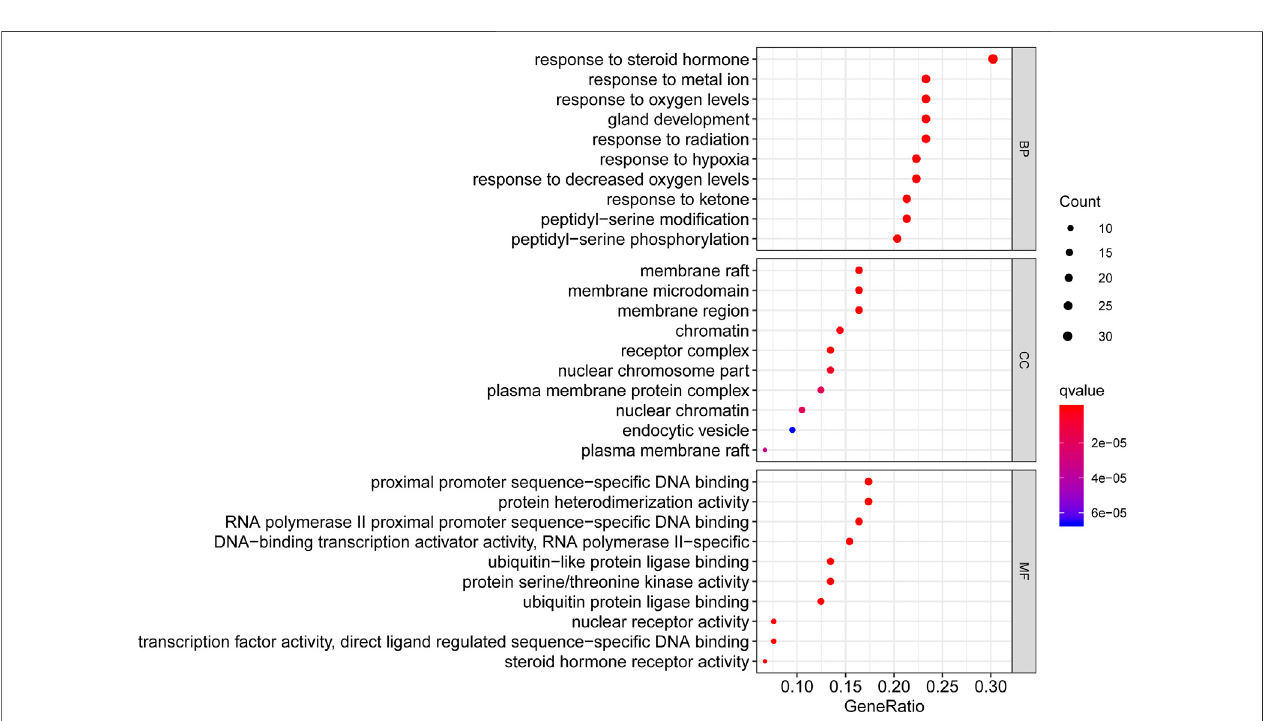
FIGURE 2 | The top 10 pathways for the GO enrichment analysis based on the common targets of the Jian-Pi-Yi-Shen formula (JPYSF) and epithelial – mesenchymal transition (EMT).